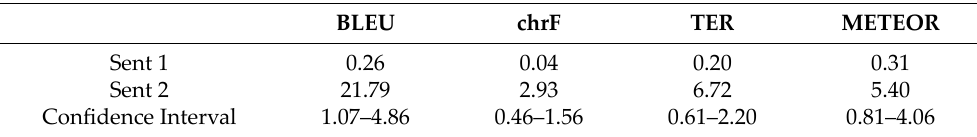
Table 6. Mean variances of two sentences across fifty shuffles. They were selected from the test set of the Spanish‑to‑English task.